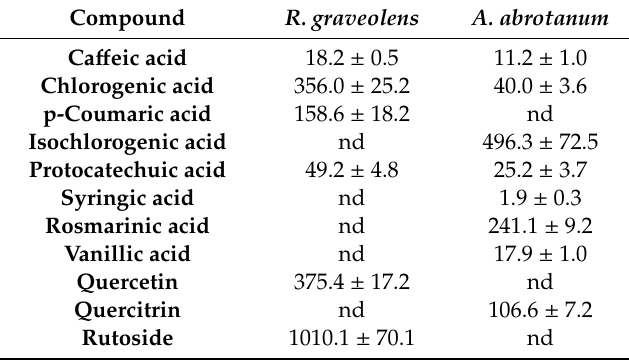
Table 1. Polyphenol contents of Ruta graveolens and Artemisia abrotanum leaf extracts (mg / 100 g dry